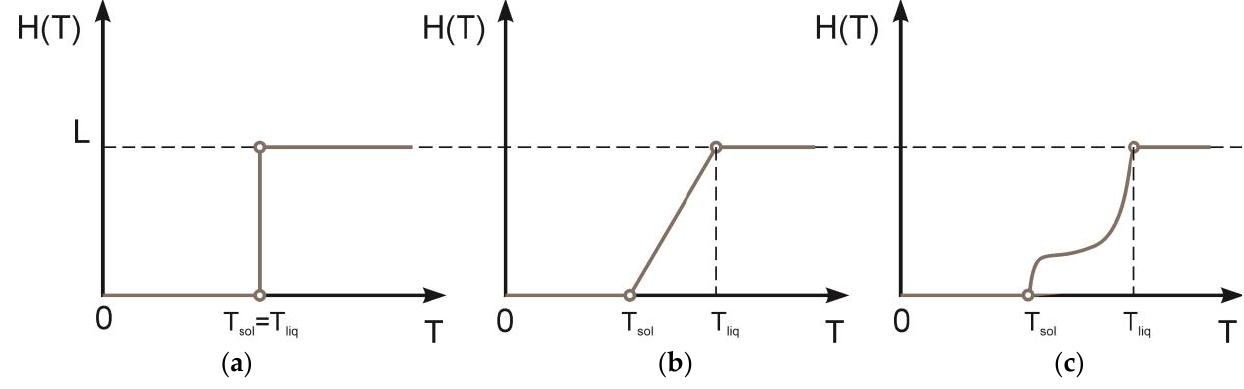
Figure 2. Phase change processes: ( a ) isothermal (for pure material); ( b ) linear; ( c ) general case.